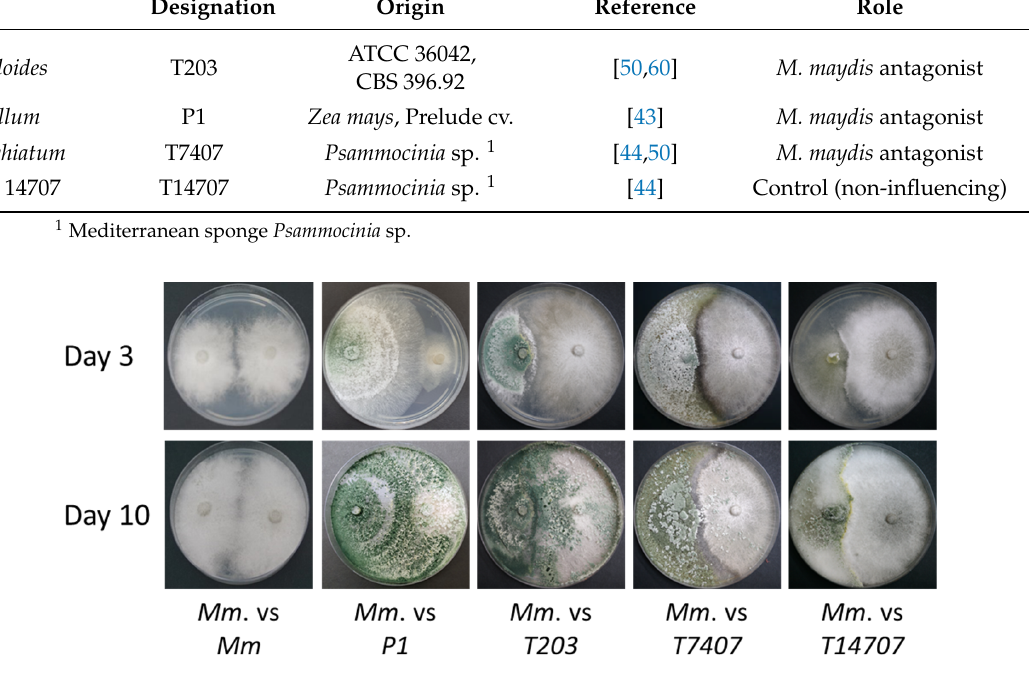
Figure 1. Mycoparasitism of Trichoderma spp. against the maize late wilt pathogen Magnaporthiopsis maydis . The photos were adapted from [18,50] with modifications. Trichoderma isolates (shown in Table 1) were seeded on the left and M. maydis ( Mm ) on the right. The Trichoderma species that restrict the pathogen’s growth or that grow above the pathogen’s mycelium are considered to have mycoparasitic potential. As can be seen, the control (non-influencing) Trichoderma sp. O.Y. 14707 was covered almost entirely by the M. maydis mycelia. The fungi were sown on rich solid substrate (PDA) plates and incubated for 3 and 10 days at 28 ± 1 ◦ C in the dark (except for P1, which was grown for 3 and 6 days). The control is a growth plate where M. maydis was seeded in both poles ( Mm vs. Mm ). Each photo is representative of five independent replicates for each confrontation